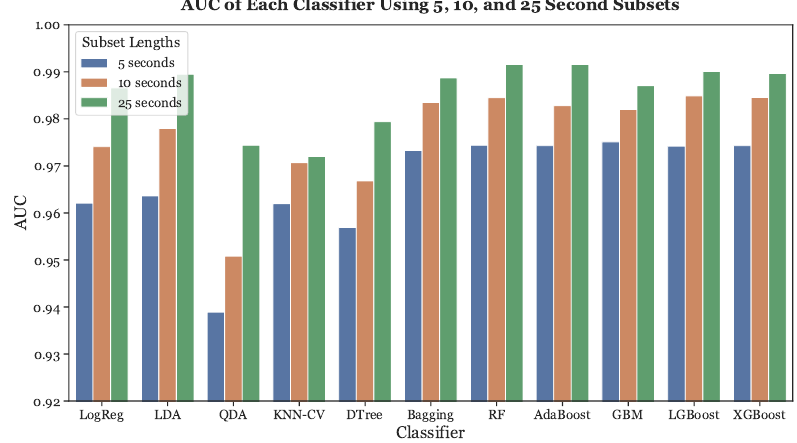
Figure 12. AUC across all subset lengths (5, 10, and 25 s) using LOOCV.